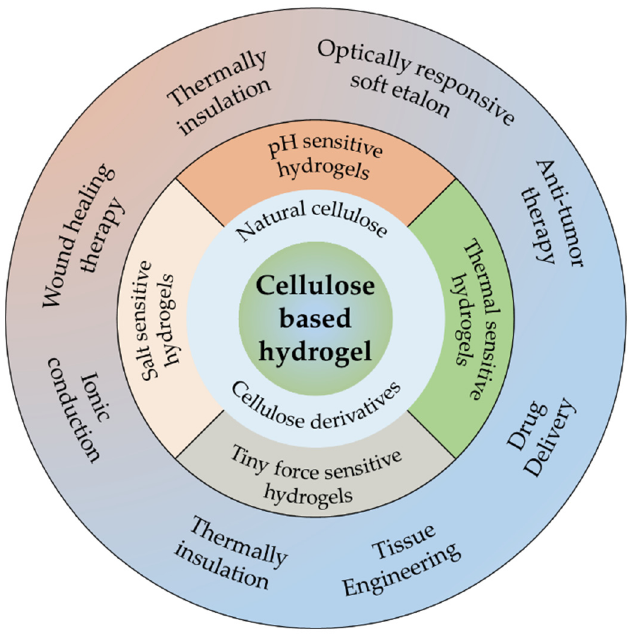
Figure 1. The recent advances of cellulose hydrogels in this review.